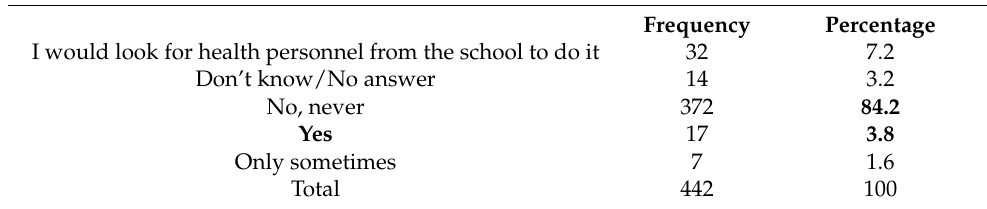
Table 3. Tooth avulsion reimplantation.